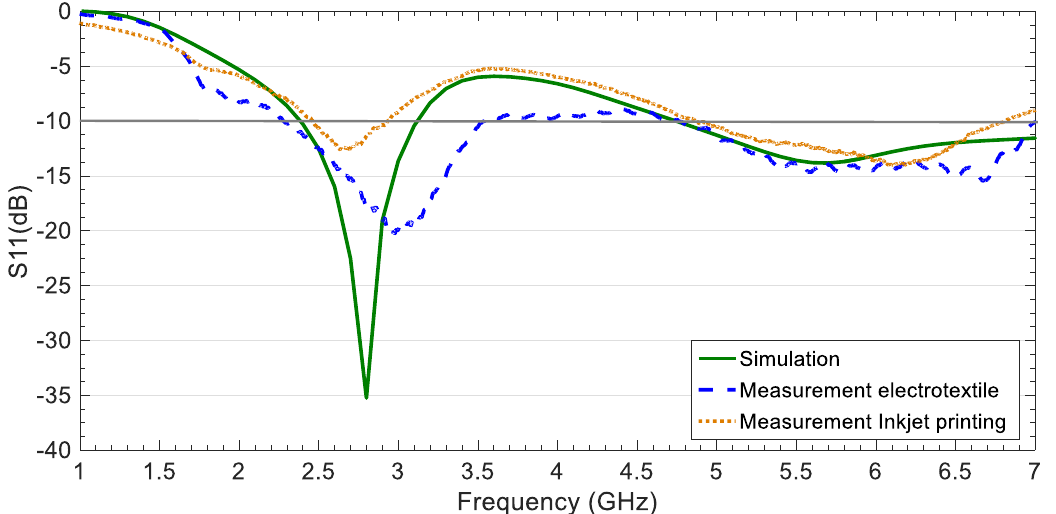
Figure 7. Return losses for the CPW-fed slot monopole antenna on ENrG’s Thin E-Strate in simulation and measurement using electrotextile and inkjet printing as metallization in the fabrication process.